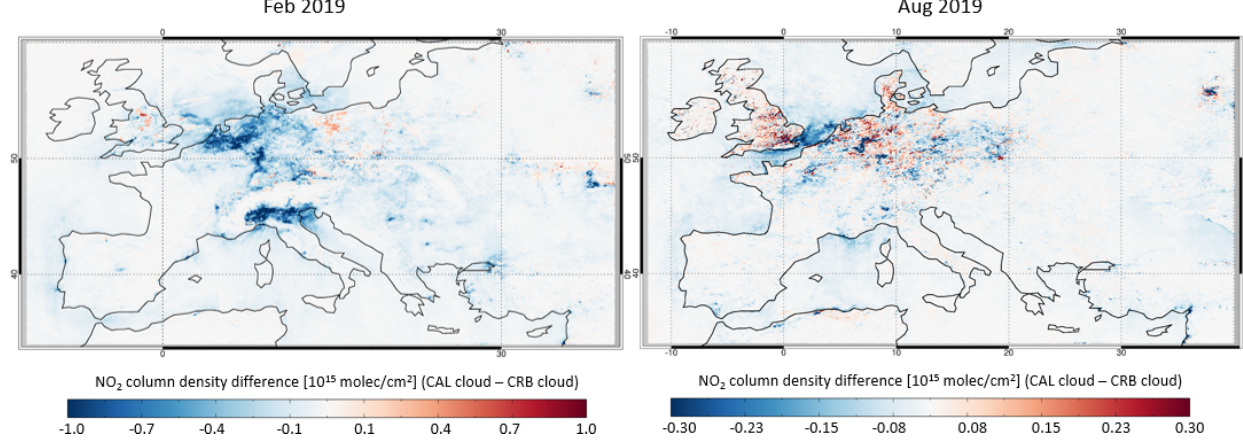
Figure 17. Differences in the tropospheric NO 2 columns retrieved using the ROCINN_CRB and ROCINN_CAL cloud models over Europe in February and August 2019. Only measurements with a cloud radiance fraction less than 0.5 are included.